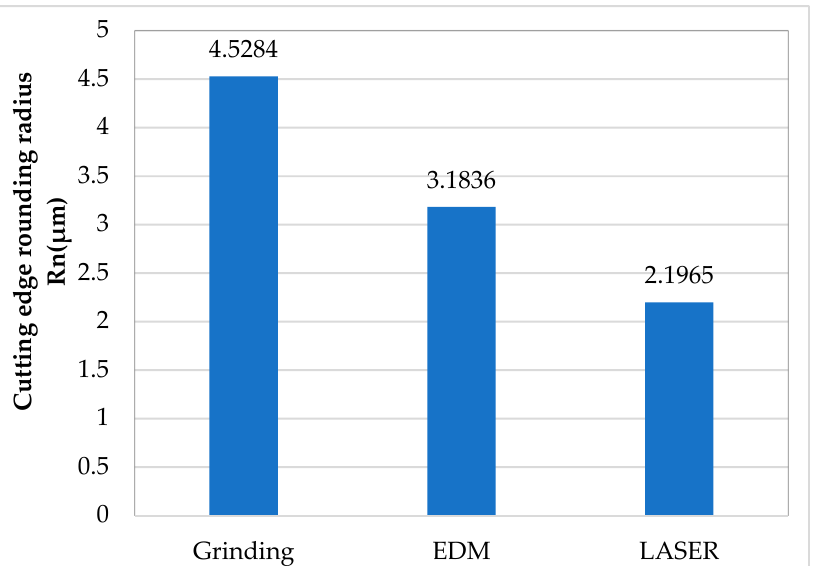
Figure 10. Mean radius parameter values comparison of the curvature of the cutting edge Rn with repeatability of 5 measurements.